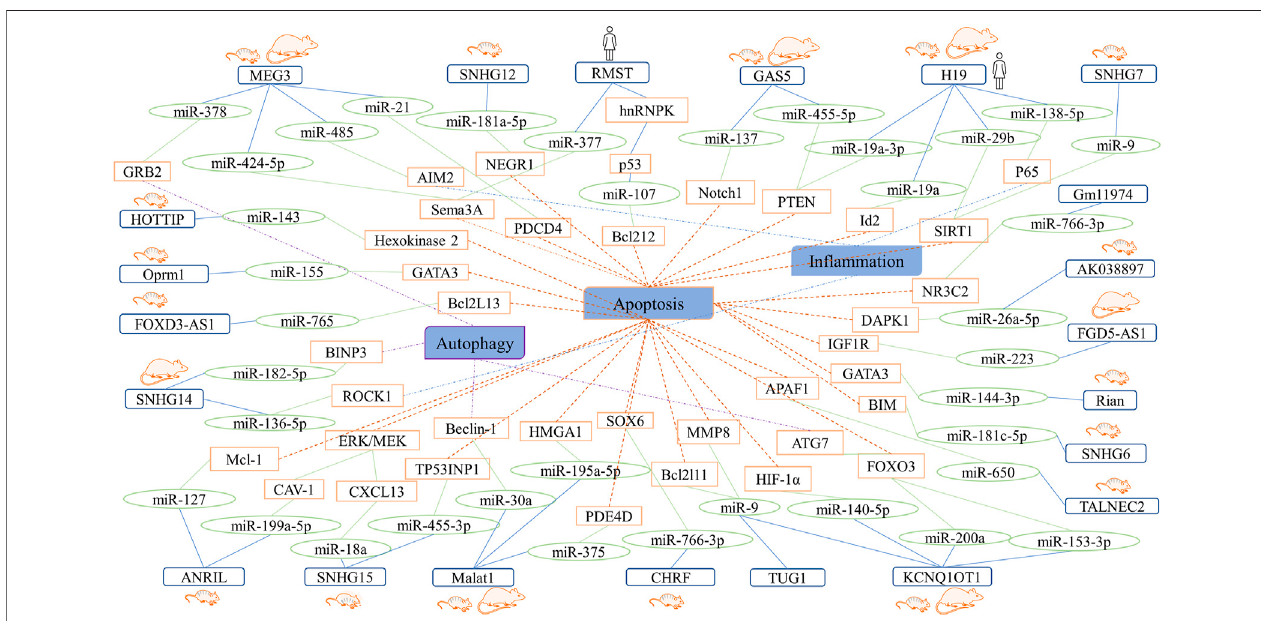
FIGURE 3 | Summary network showing the roles of LncRNA-miRNA-mRNA axes in